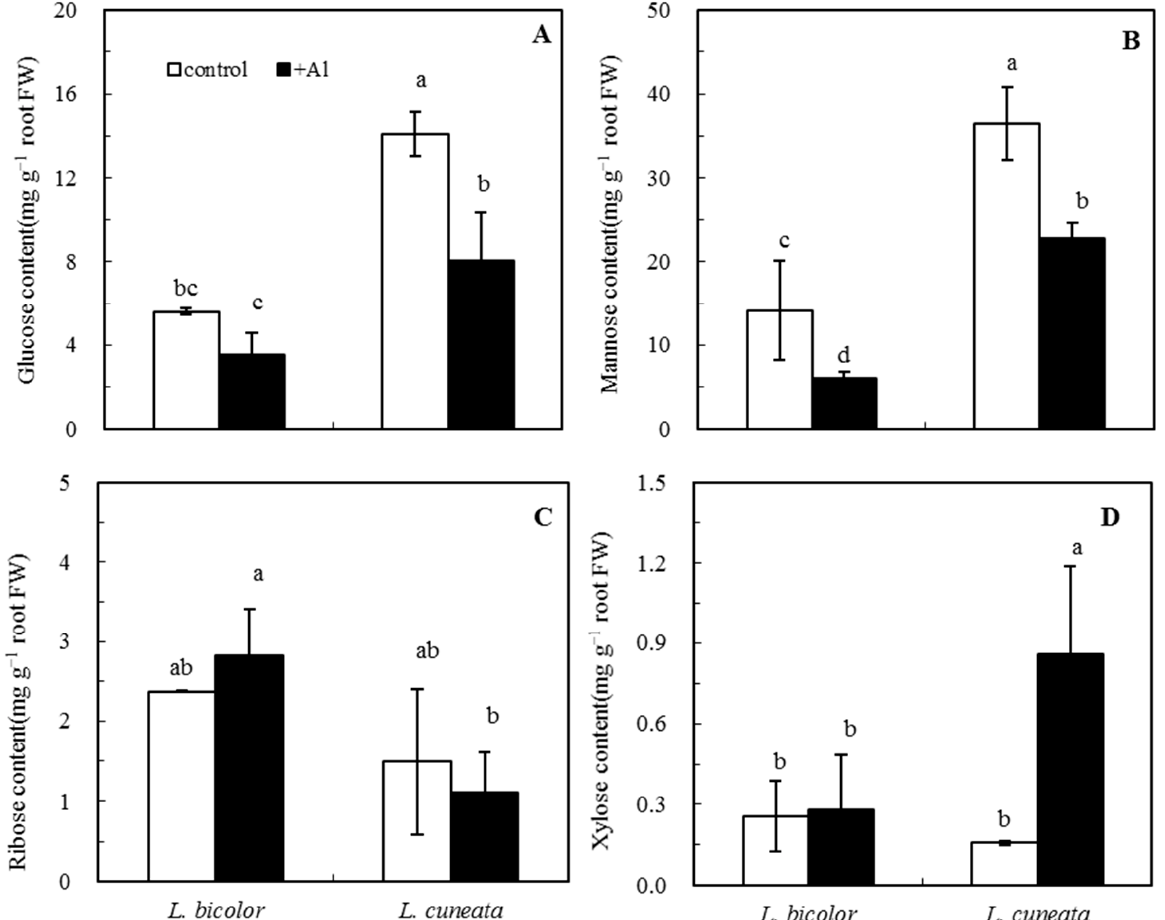
Figure 6. Effects of Al treatments on the contents of monosaccharides in root apices of two Lespedeza species. ( A ) glucose, ( B ) mannose, ( C ) ribose, and ( D ), xylose. Five-day-old seedlings were exposed to 0.5 mM CaCl 2 solutions (pH 4.5) with or without 50 µ M Al for 24 h. Significant differences between mean values are indicated by different letters at the p < 0.05 level (Tukey test). Values shown are means ± SD ( n = 3).